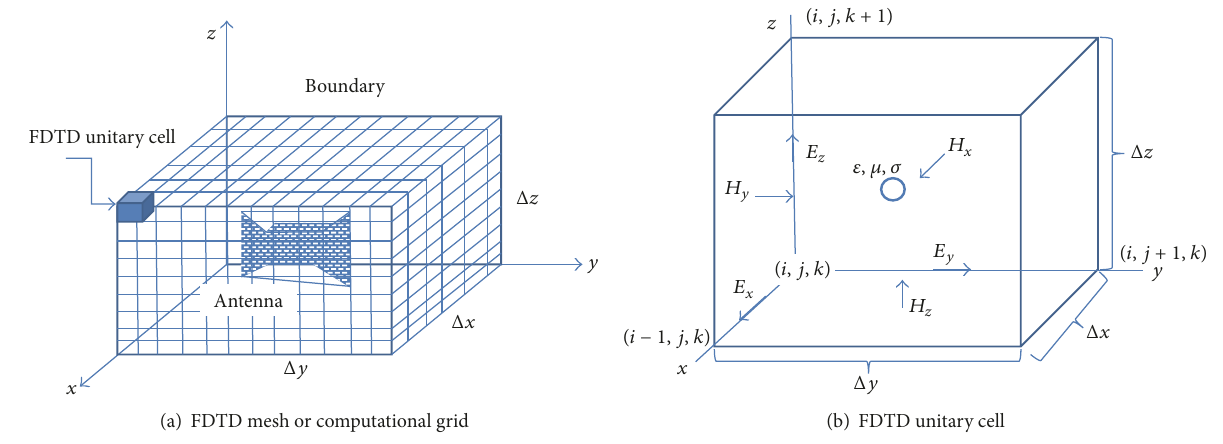
Figure 1: FDTD (a) grid and (b) field components in a unitary